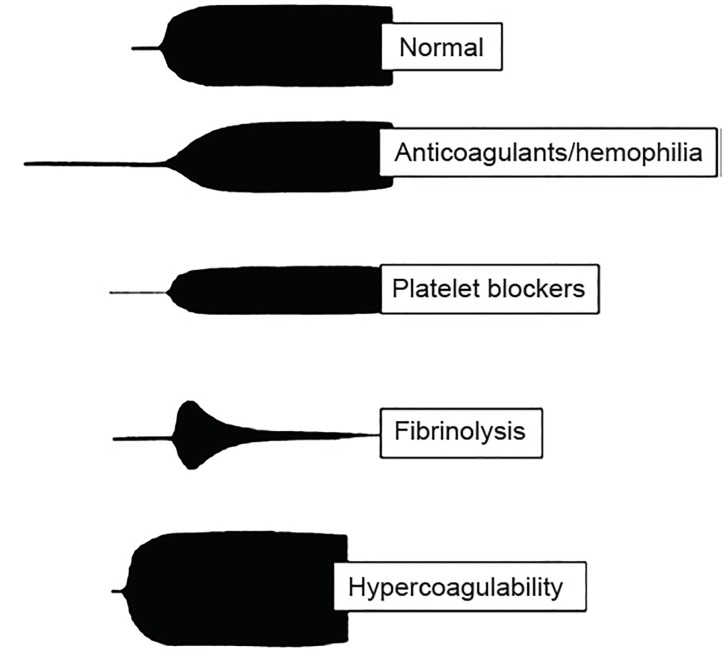
Interpretation of thromboelastography/rotational thromboelastometry graphics.10